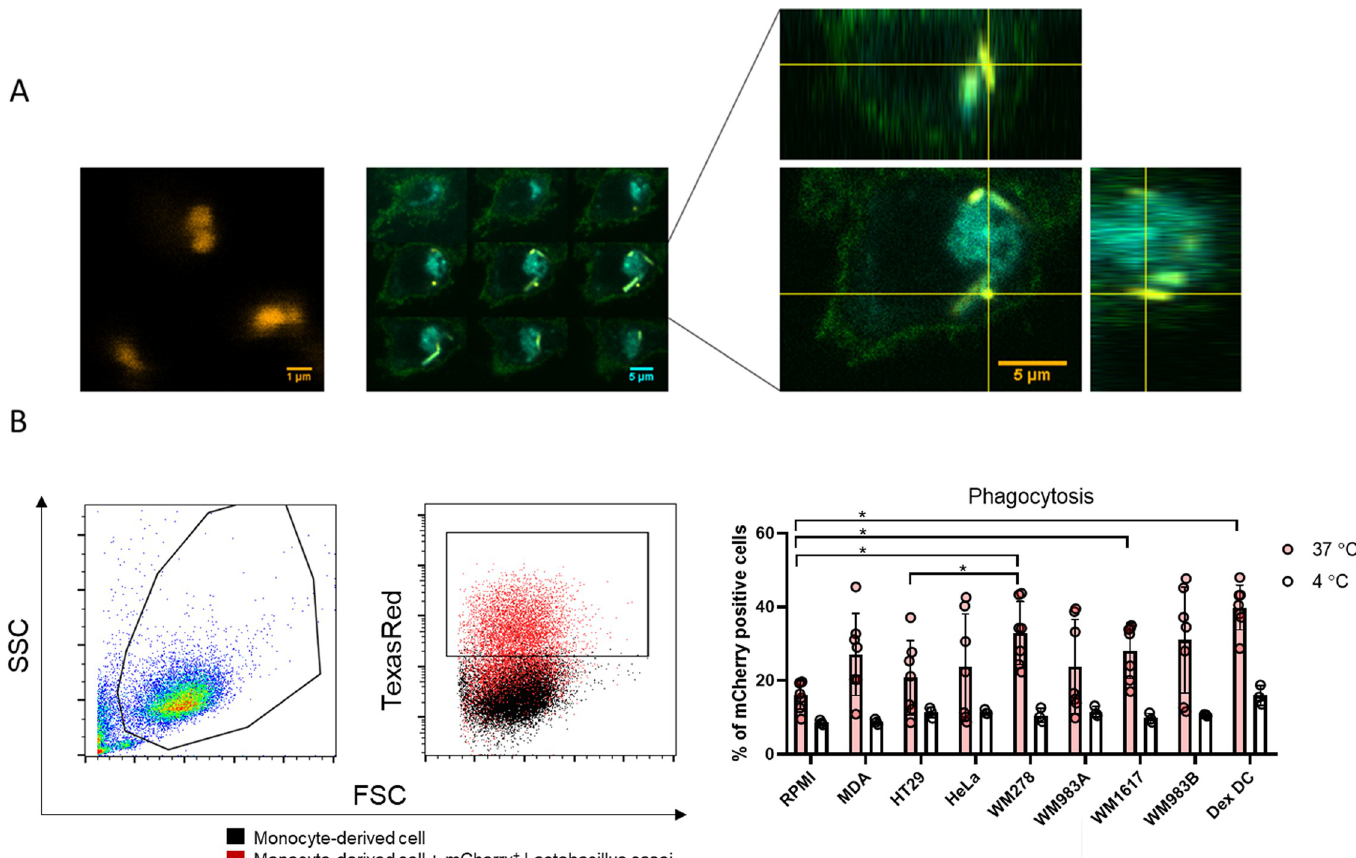
Fig 4. TU-CMs alter the phagocytic capacity of monocyte-derived cells. (A) CD14 + monocytes were cultured with 100 ng/ml IL-4, 80 ng/ml GM-CSF ± MDA-MB231-, HeLa-, HT29-, WM278-, WM1617-, WM983A- or WM983B-CM for four days. The phagocytic capacity of tumor cell line-educated moDCs was measured by the uptake of mCherry-expressing Lactobacillus casei . Microscopic images show DCs labeled by FITC conjugated HLA antigens (green), nuclei were visualized with DAPI (cyan) and mCherry-expressing Lactobacillus casei (yellow). The scale bar is 1 μ m (left picture) or 5 μ m (middle and right picture). In the middle Z-stack images of the cells, Z-stack images were collected in 1 μ m sections from the bottom to the top of the cell, scale bar is 5 μ m. In the figure on the right is the orthogonal view of Z-stack images. On the top is Z-projection in the X-Z direction, on the right is the Z-projection in the Y-Z direction. The yellow lines indicate the Z-depth of the optical slice. The yellow lines show the orthogonal planes of the X–Z and Y–Z projection, respectively. (B) In vitro differentiated four-day monocyte-derived cells were coincubated with mCherry- labeled L . casei for 4 h at a ratio of 1:10 at 37˚C and 4˚C as a control. Phagocytic activity of moDCs was measured by detecting mCherry fluorescent protein-positive moDCs with flow cytometry after 4h. The diagram shows the mean plus SD of seven (37˚C) or three (4˚C) independent experiments. Boxplot shows one representative sample from the seven independent experiments. Significance is indicated by � P < 0.05.